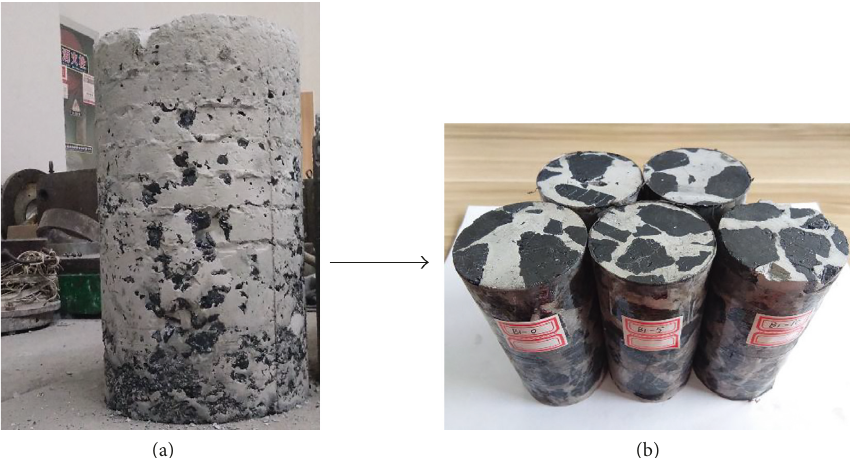
500mm) from the inner barrel and (b) small grouted standard cylindrical specimens ×